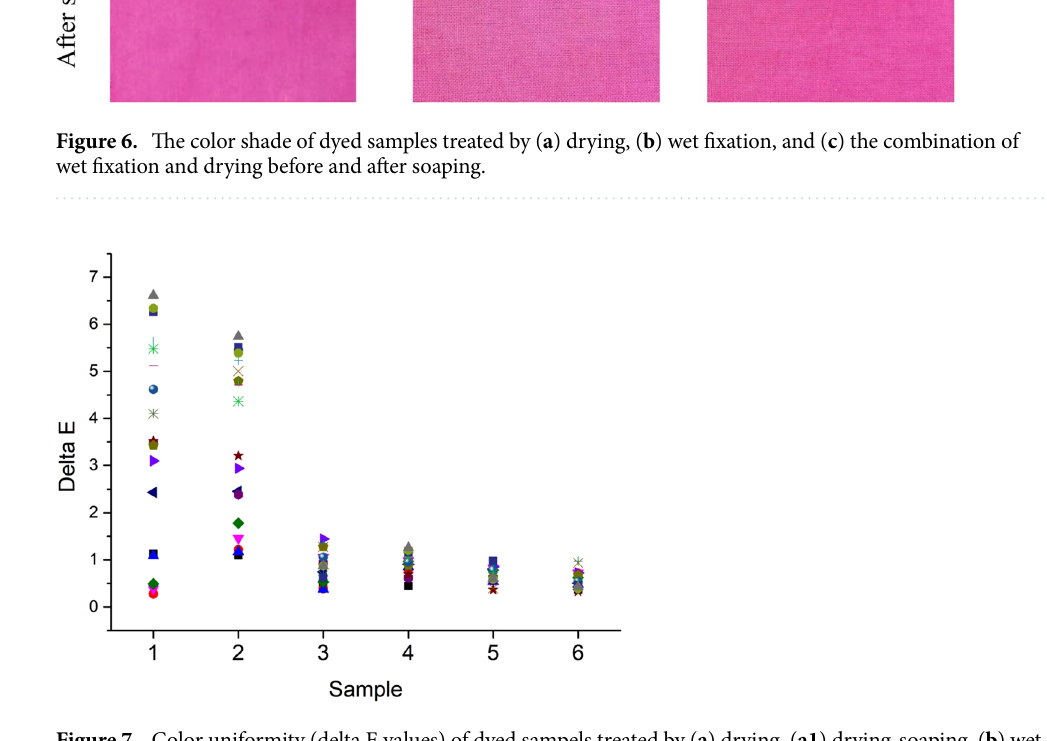
Figure 7. Color uniformity (delta E values) of dyed sampels treated by ( a ) drying, ( a1 ) drying-soaping, ( b ) wet fixation, ( b1 ) fixation-soaping, ( c ) wet fixation-drying, and ( c1 ) wet